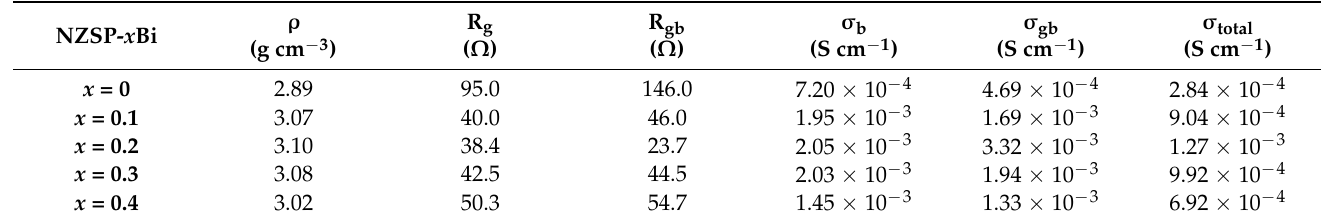
Figure 4. ( a , b ) Low-temperature, room-temperature and high-temperature Nyquist plots of Na 3 Zr 2 Si 2 PO 12 electrolyte. ( c ) Arrhenius plot of Na 3 Zr 2 Si 2 PO 12 electrolyte. ( d , e ) Low-temperature, room-temperature and high-temperature Nyquist plots of Na 3 Zr 2 Si 2 PO 12 - electrolyte. ( f ) Arrhenius plot of Na 3 Zr 2 Si 2 PO 12 -0.2Bi electrolyte. To investigate the Na plating/stripping behavior, the Na/Na 3 Zr 2 Si 2 PO 12 /Na and Na/Na 3 Zr 2 Si 2 PO 12 -0.2Bi/Na symmetrical batteries were assembled. Critical current density (CCD) is a critical parameter to evaluate the tolerance of Na dendrite growth [33]. As shown in Figure 5a,b, the CCD of the Na/Na 3 Zr 2 Si 2 PO 12 /Na symmetric cell is 0.35 mA cm − 2 , which is slightly higher than that of Na/Na 3 Zr 2 Si 2 PO 12 -0.2Bi/Na (0.30 mA cm − 2 ). The de- crease of CCD after Bi 2 O 3 introduction originates from the spontaneous reaction of Na